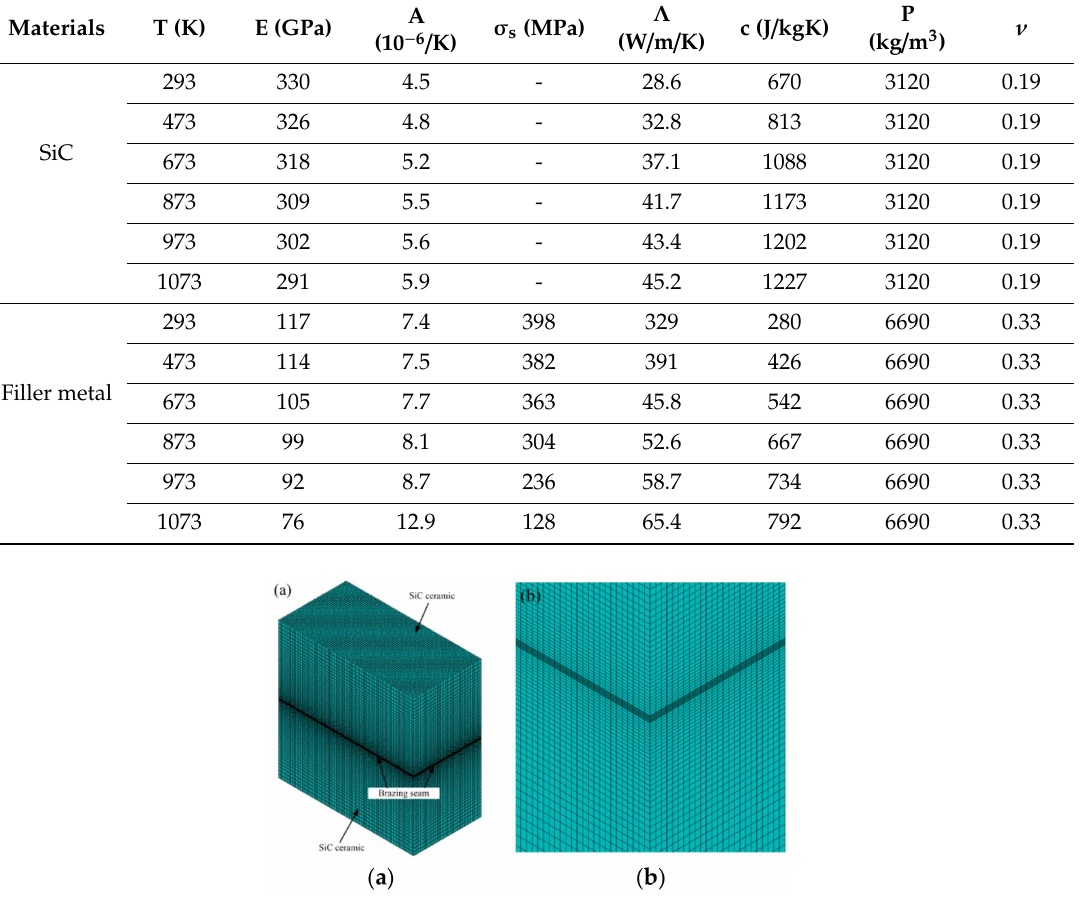
Table 1. Physical properties of SiC ceramic and filler metal (80Zr20Cu (wt.%)).